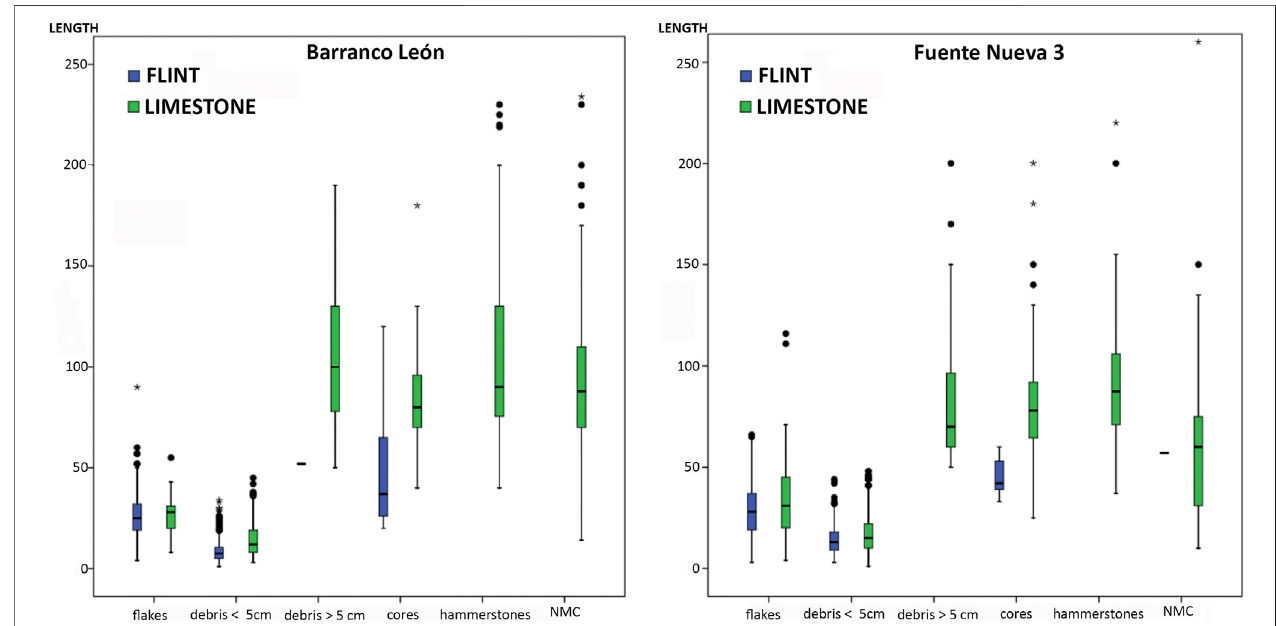
FIGURE 8 | Boxplot for the length of the main categories in BL (left) and FN3 (right): fl akes (only complete), debris < 50 mm, debris > 50 mm, cores, hammerstones and non-modi fi ed clasts (NMC).